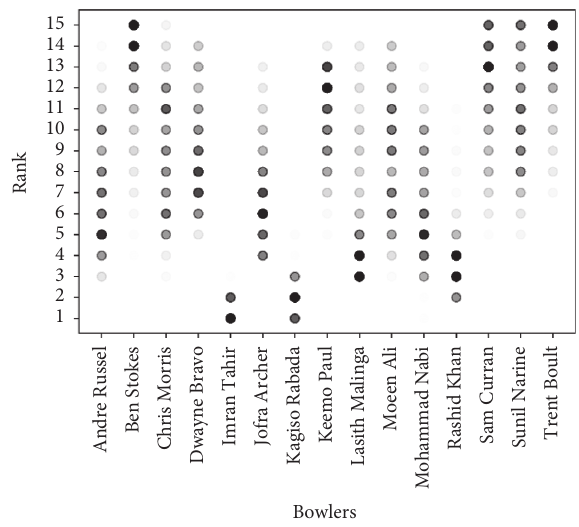
Figure 6: Heat map for bowlers ranks generated by